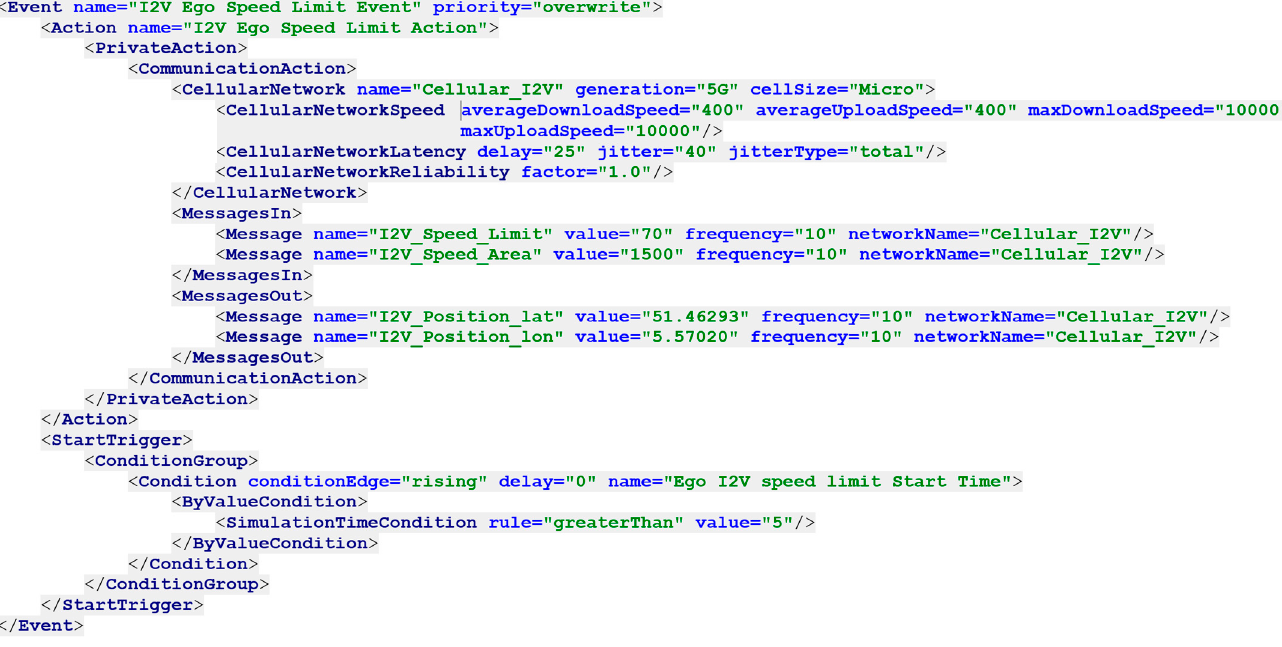
Figure 10. Example of entering a new ISA speed limit area.